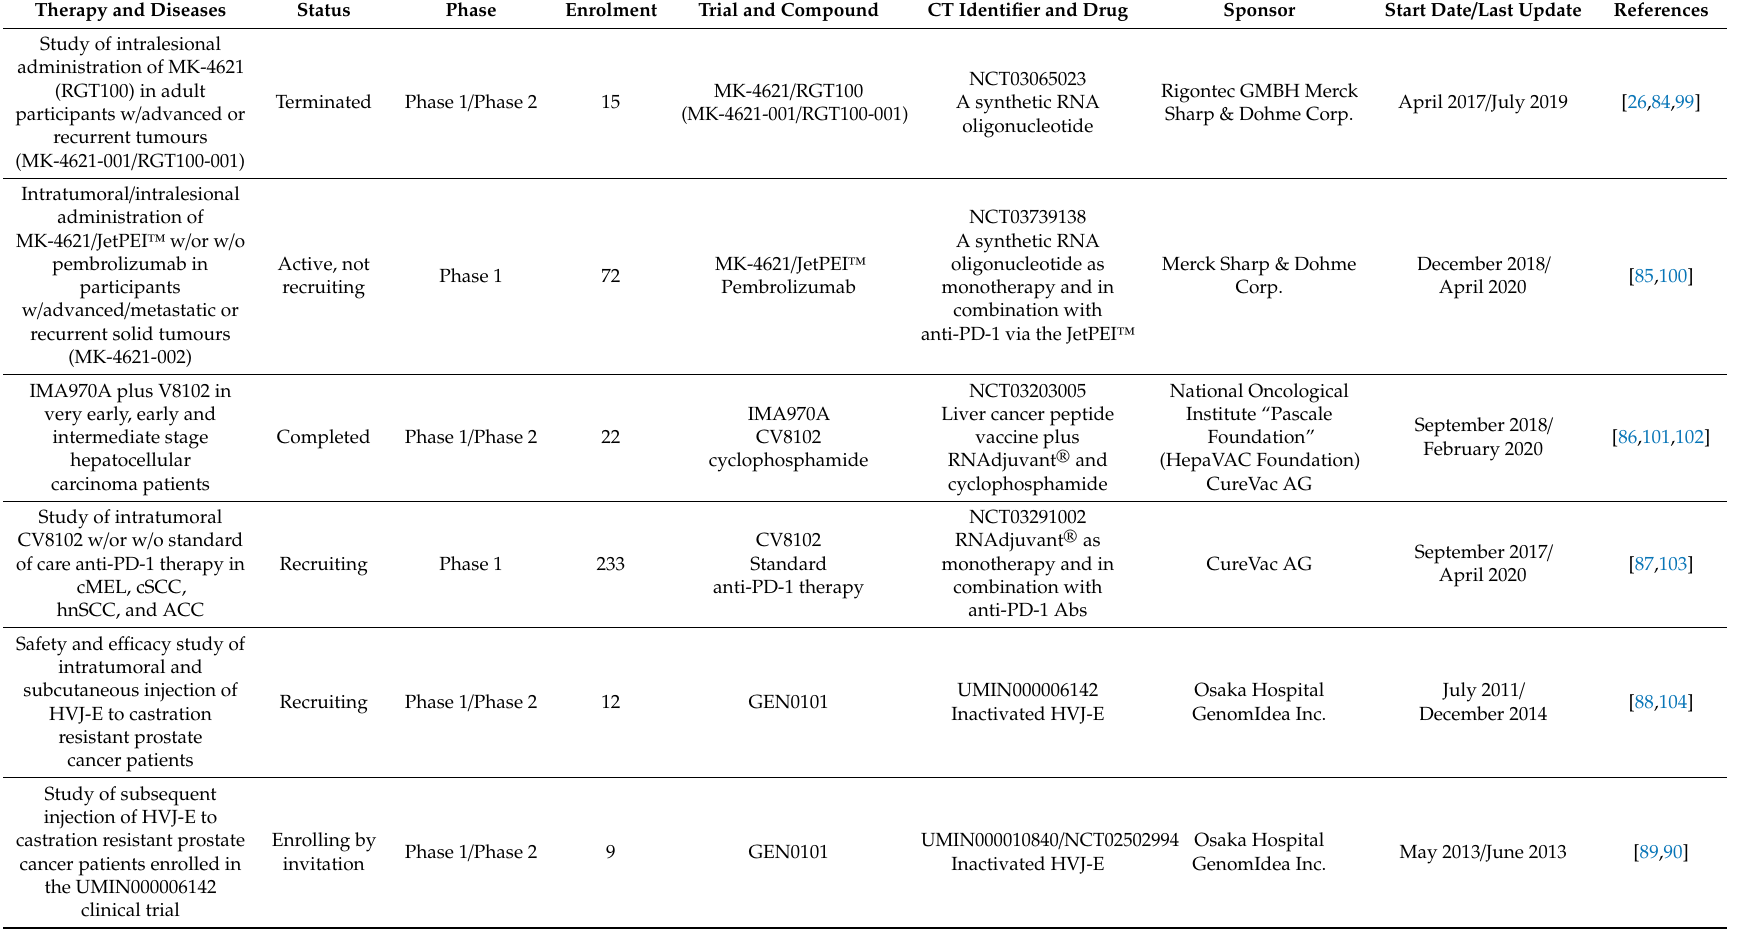
Table 1. Representative clinical trials in oncology using RIG-I